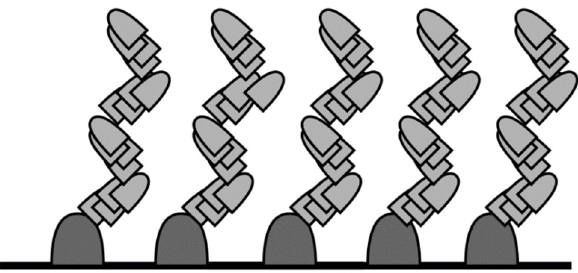
Figure 2. Cross section of plate with zigzag pattern.